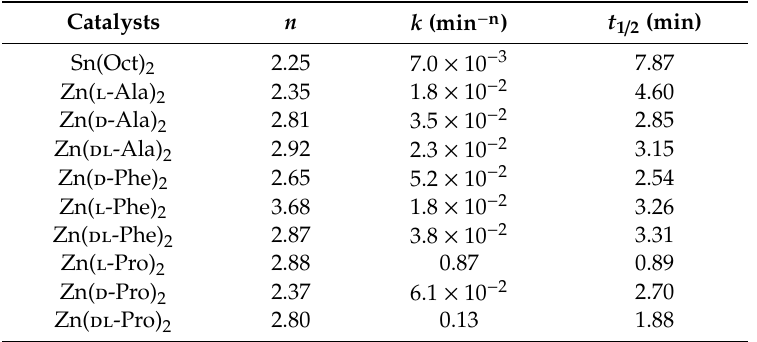
Table 2. Isothermal crystallization kinetic parameters of the obtained PLLA by di ff erent catalysts at 125 ◦